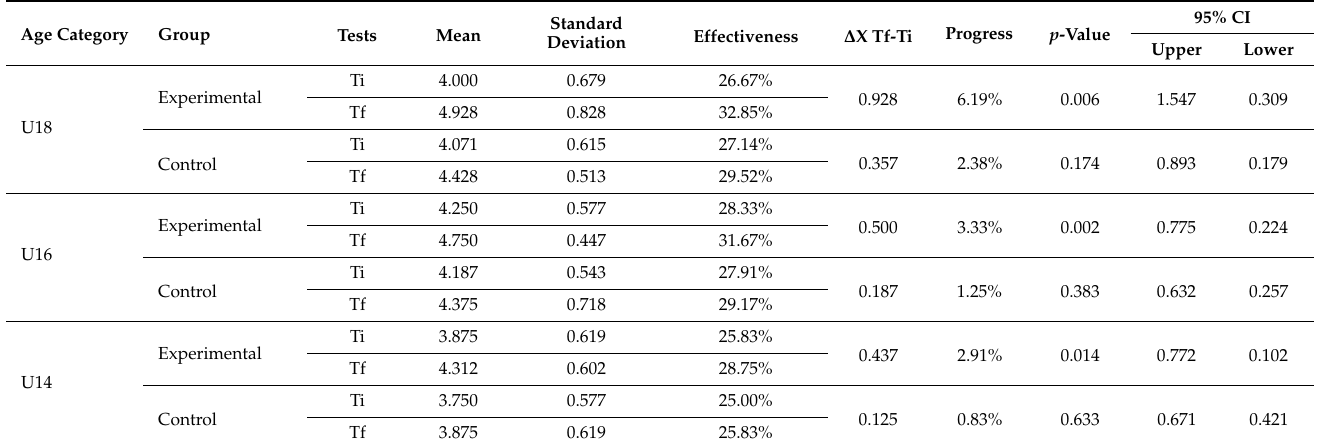
Table 3. Descriptive statistics for the Shoot-Run Test for the experimental and control male groups U14, U16, and U18.